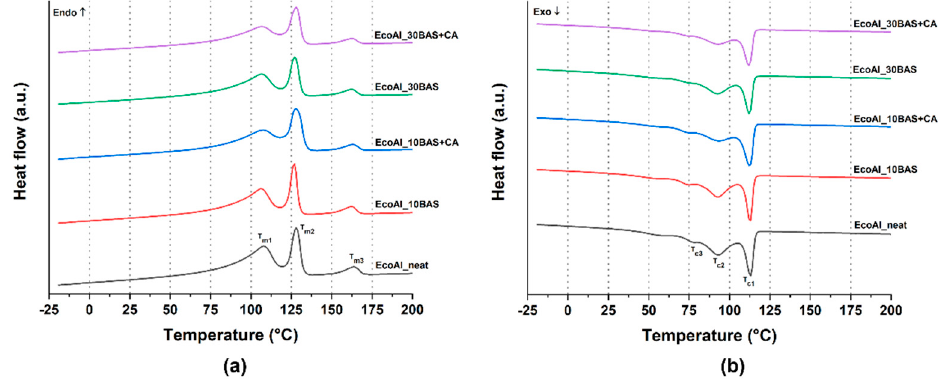
Figure 2. DSC 2nd heating scan ( a ) and cooling scan ( b ) for EcoAllene-based composites. Table 3. Thermal properties of composites obtained from differential scanning calorimetry (DSC) analysis (T m = melting temperature; T c = crystallization temperature. Numbers 1 to 3 refer to the temperatures labeled in Figure 2).